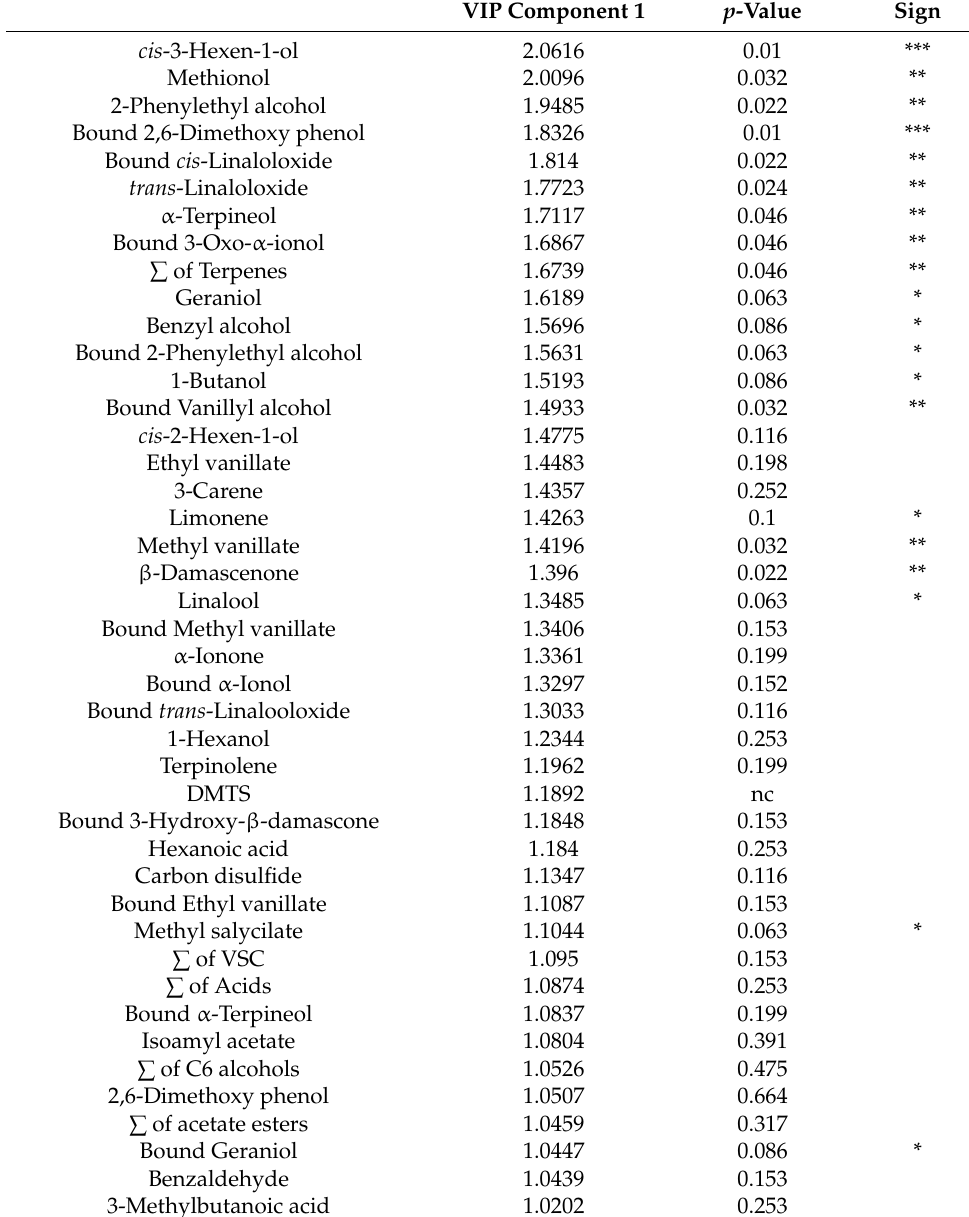
Table 2. Variable of Importance for the Projection (VIP) score, statistical significance, level of signifi- cance ( p < 0.1 *; p < 0.05 **; p < 0.01